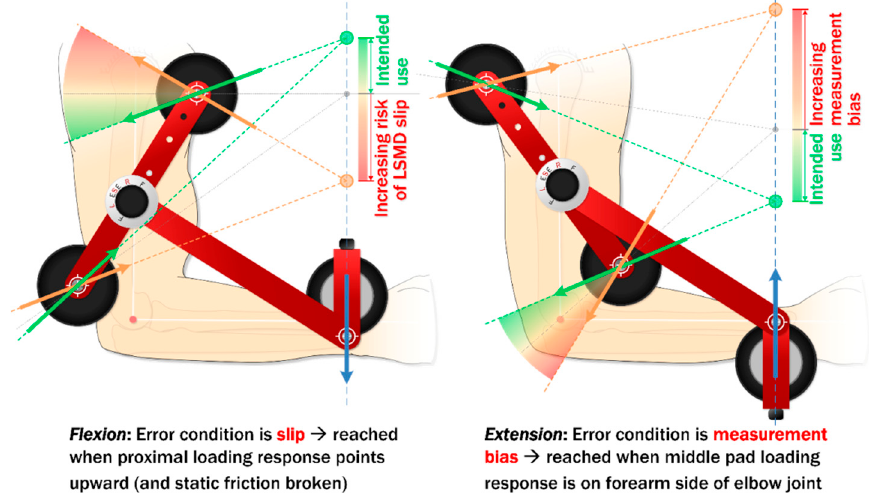
Figure 7. Biomechanical explanation of device measurement fidelity limitations.